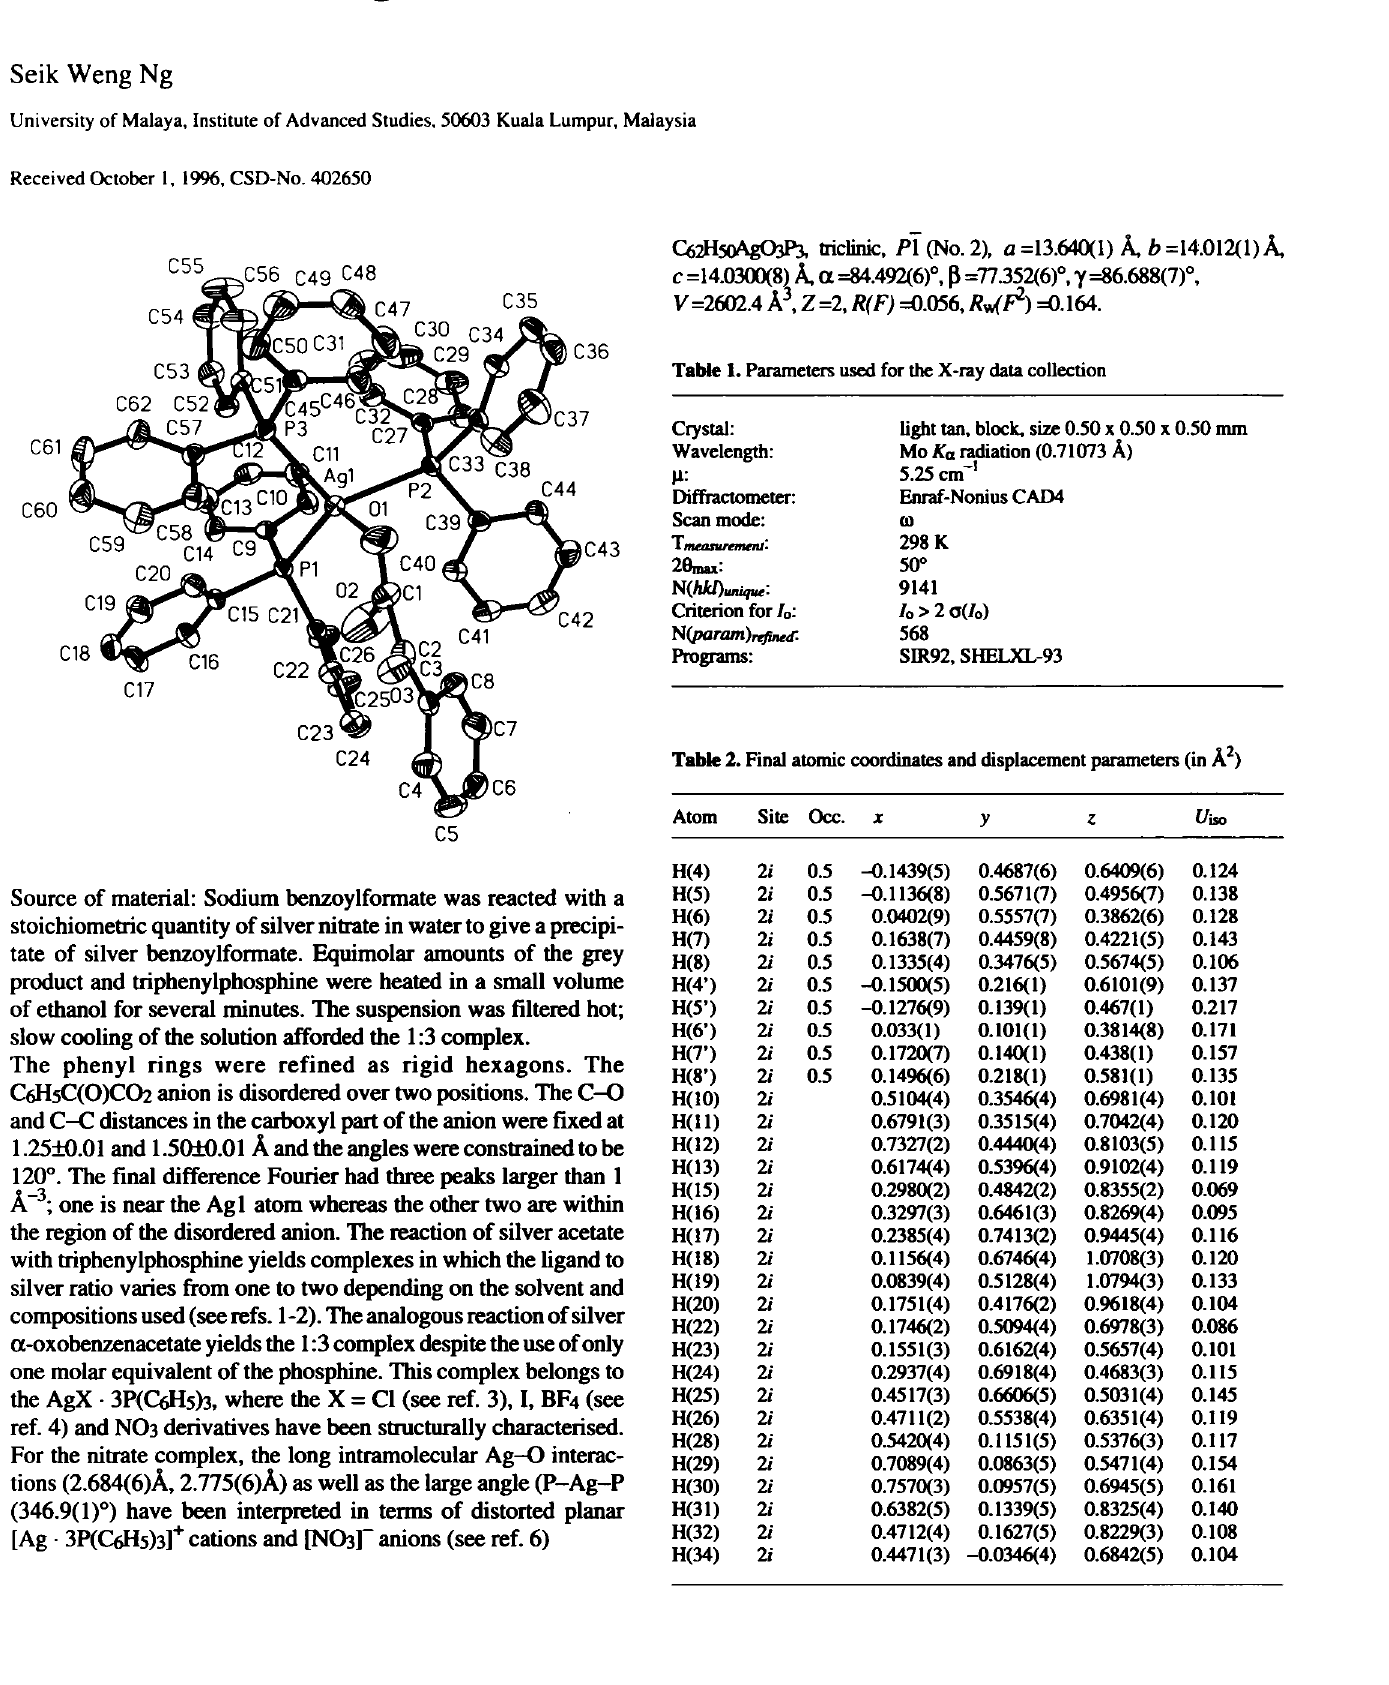
Table 1. Parameters used for the X-ray data collection